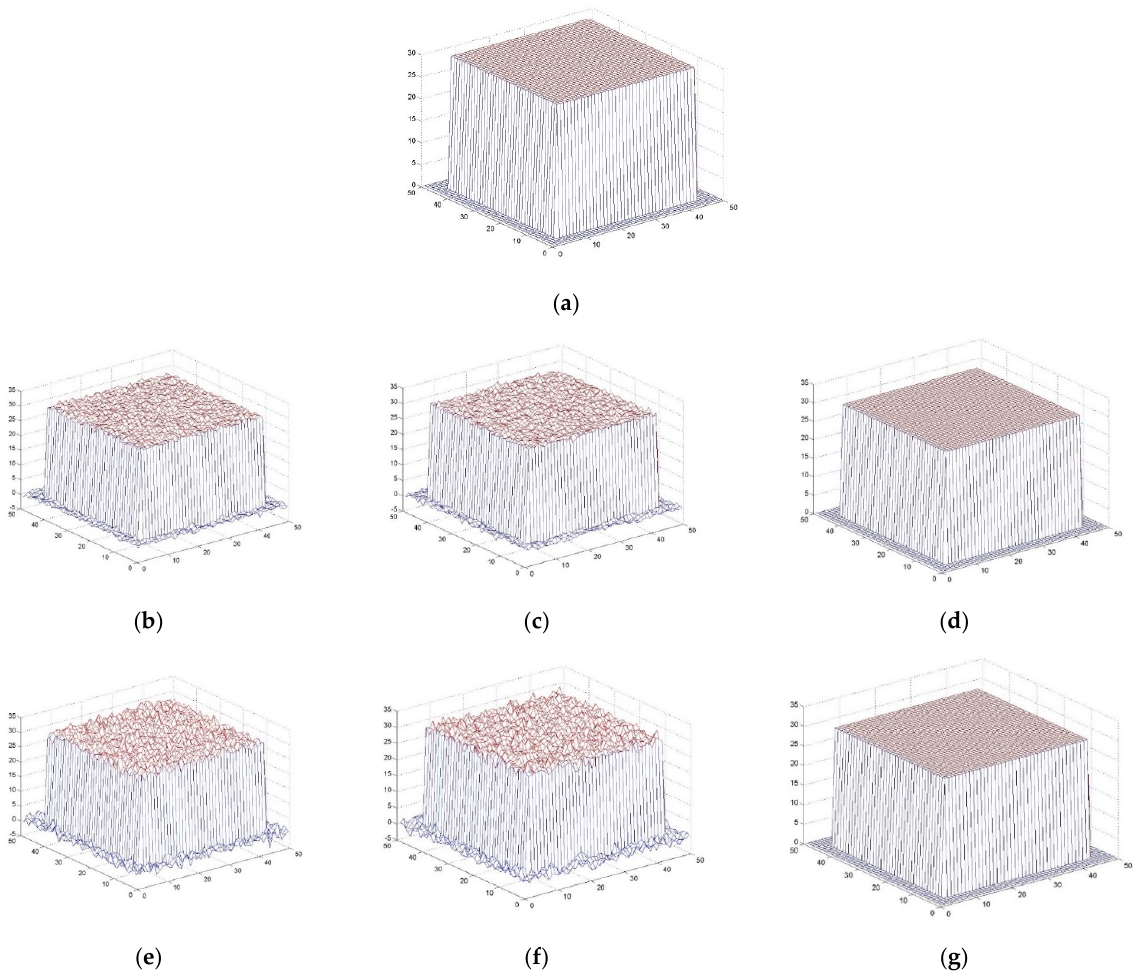
Figure 4. Comparison of the effect before and after the fusion of flat-roofed buildings with different variance Gaussian noise. ( a ) DSM of the truth map for flat-roofed building. ( b ) DSM 1 variance 0.5. ( c ) DSM 2 variance 0.5. ( d ) DSM after fusion variance 0.5. ( e ) DSM 1 variance 1. ( f ) DSM 2 variance 1. ( g ) DSM after fusion variance